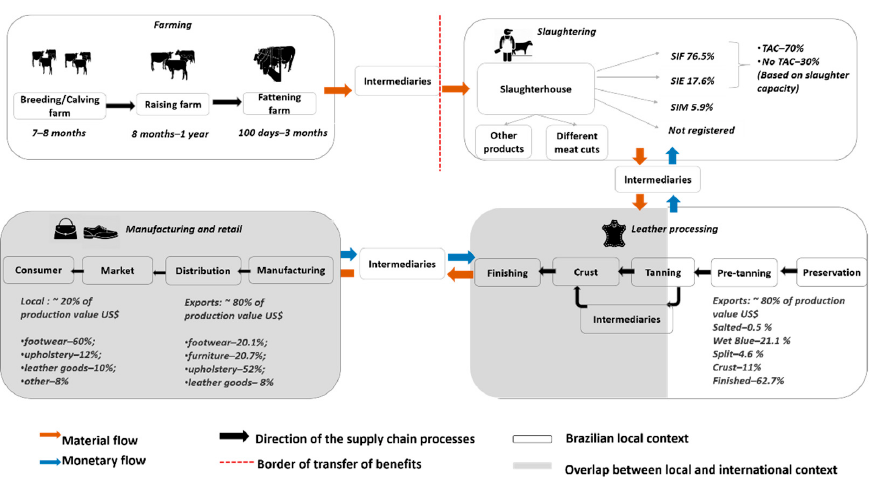
Figure A1. Leather supply chain in Brazil and its different segments. Source: author’s own elabora- tion based on data taken from IBGE and CICB [113,118].